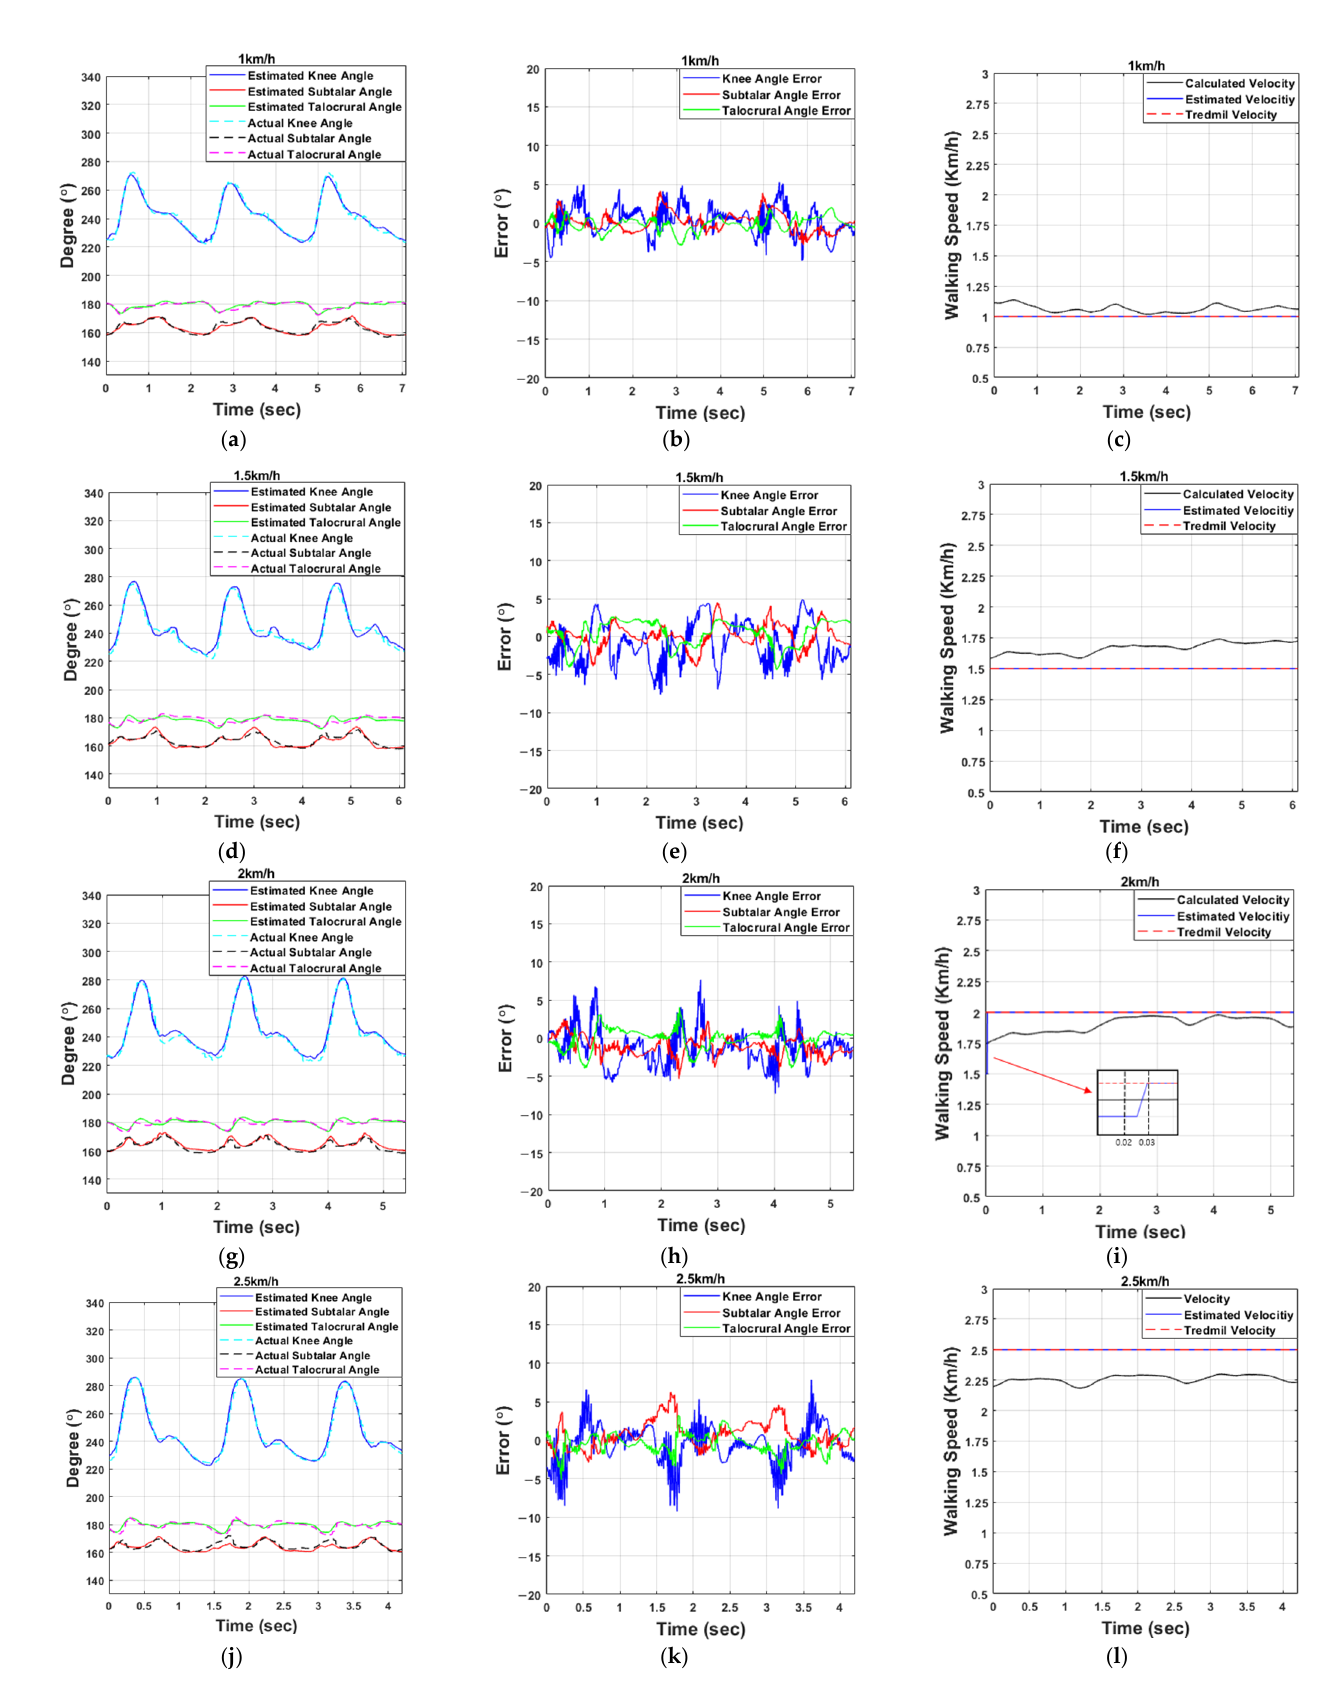
Figure 8. Experimental results for estimating the knee and ankle joint angles: ( a , d , g , j ) Results of estimating the angles of the knee and ankle. ( b , e , h , k ) Results of the angle estimation errors. ( c , f , i , l ) Results of the walking speed estimations (from top to bottom, 1, 1.5, 2, and 2.5 km/h).